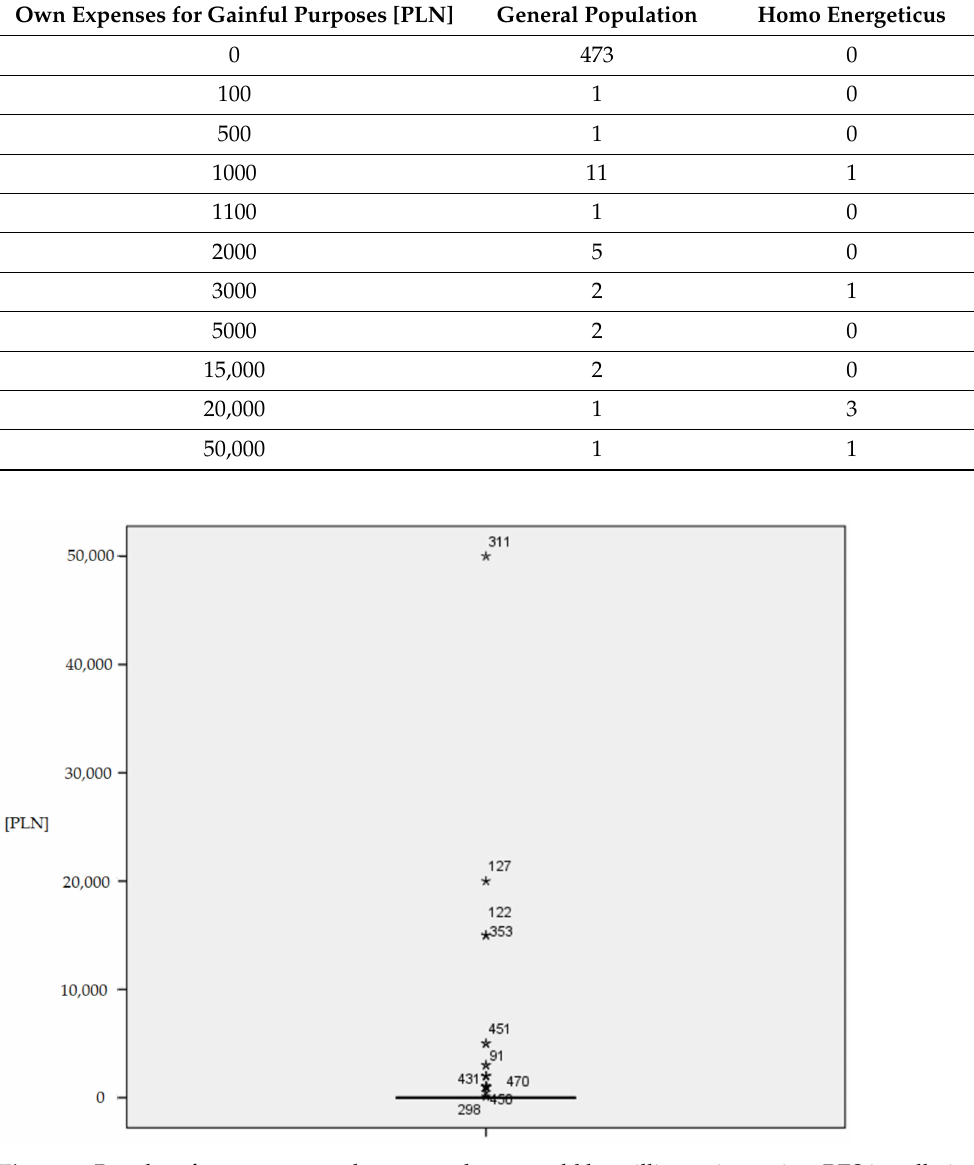
Figure 8. Boxplot of own expenses that respondents would be willing to invest in a RES installation for gainful